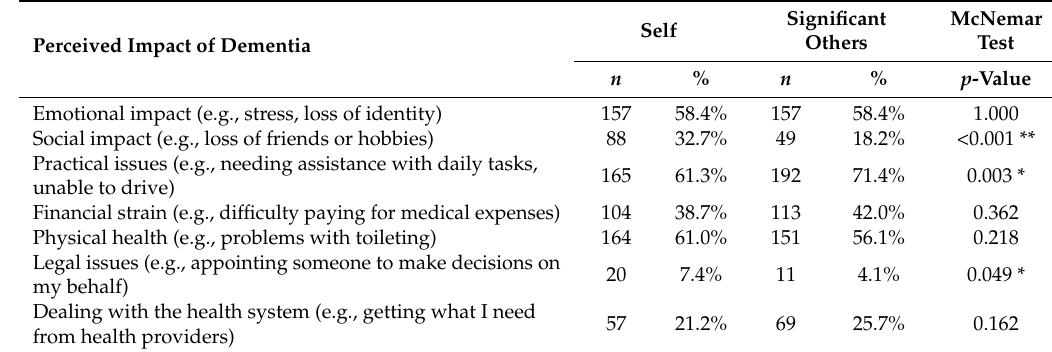
Table 2. Perceived impact of dementia to self and significant others (select up to 3 items).